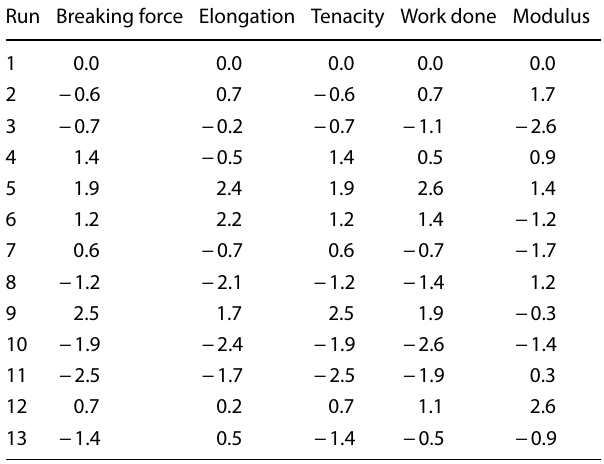
Table 12 Box-behnken design (BBD) analysis standard error (%) val- ues of expermental with predicted values of responses Run Breaking force Elongation Tenacity Work done Modulus